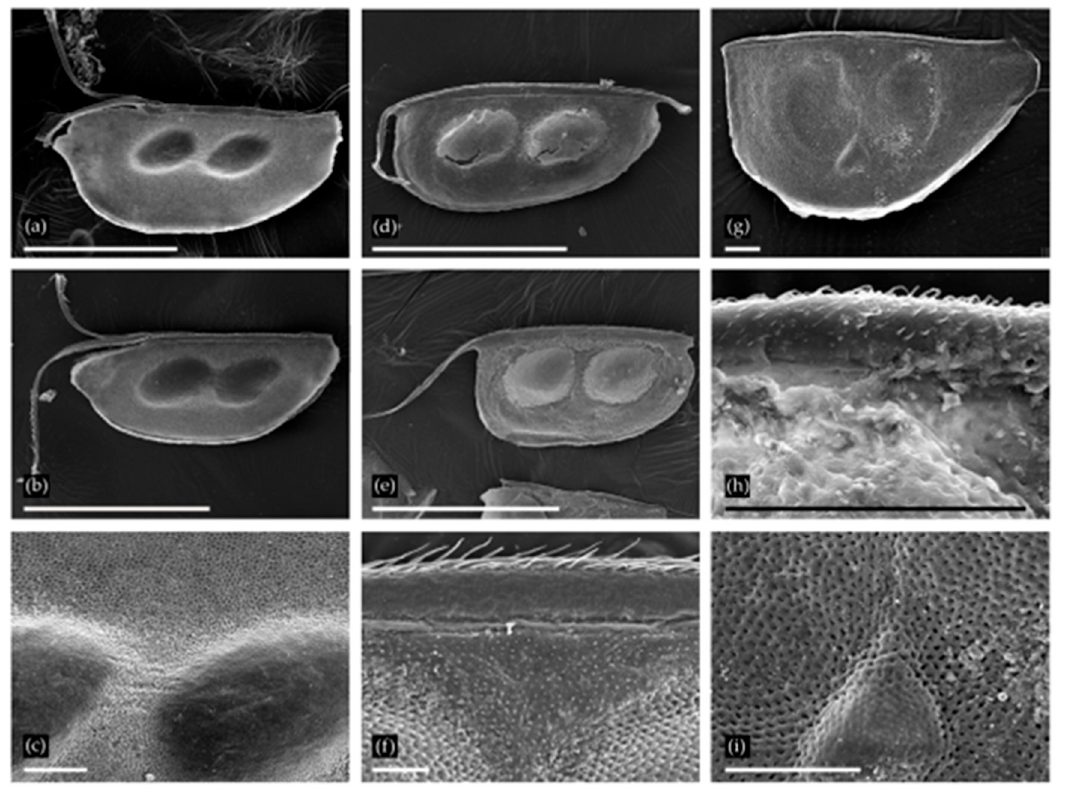
Figure 2. Ephippia of Daphnia from two localities: ( a – c ) D . ( Ctenodaphnia ) similis from Nozhiy, general view of two ephippia and sculpture in the region of egg loculi; ( d – f ) D . ( Ctenodaphnia ) magna from Urtuy, general view of two ephippia and sculpture in dorsal portion. ( g – i ) D . ( Daphnia ) cf. pulex from Urtuy, general view, armature of dorsal margin and sculpture in the region of egg loculi. Scale bars: 1 mm for a – b, d, G; 0.1 mm for c, f, h – i.